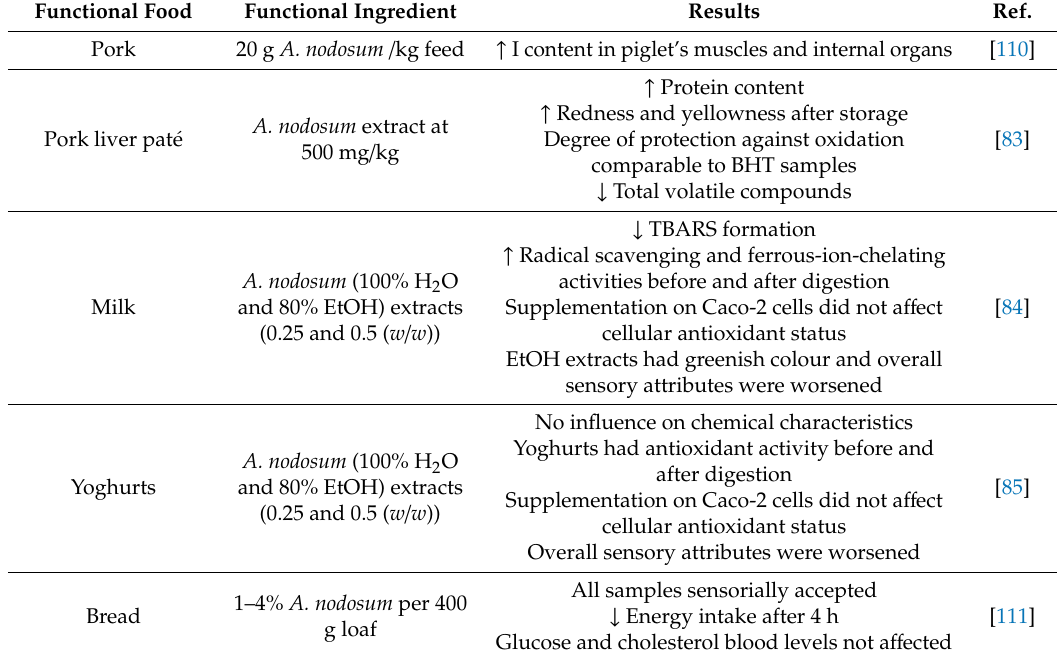
Table 4. Selected studies reporting the e ff ects of the incorporation of A. nodosum or isolates as ingredients in di ff erent food matrices.